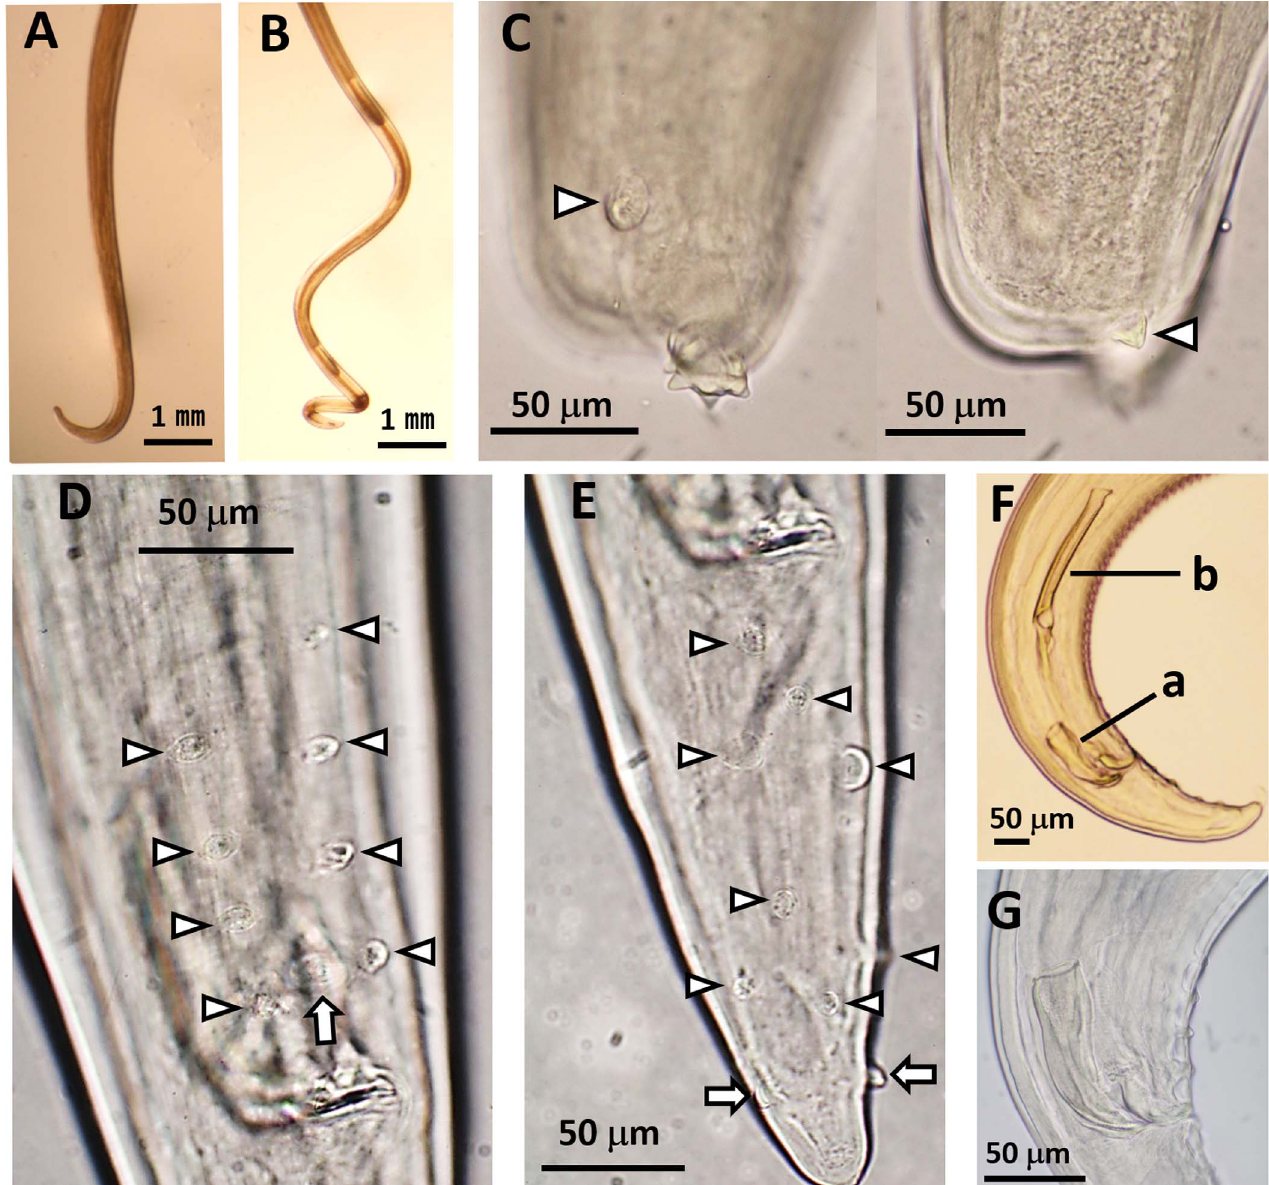
Figure 3. General view of the posterior parts of the nematodes. (A) A female and (B) male nematode. (C) Arrowheads indicate a pair of lateral caudal appendages of a female. (D) The cloacal anterior side of a male with four pairs of precloacal papillae (arrowheads) and one median papilla anterior to the cloaca (arrow). (E) The cloacal posterior side of a male with four pairs of post-cloacal papillae (arrowheads) and a pair of lateral caudal appendages (arrows). (F) (a) The right and (b) left spicules of the posterior end of a male. (G) The right spicule of a